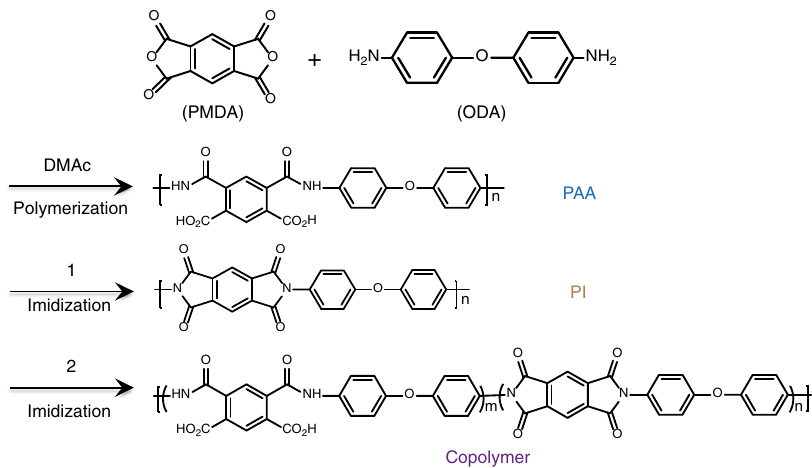
Fig. 1 Synthetic route to poly (amic acid) (PAA), polyimide (PI) and copolymer. Preparation of polymer